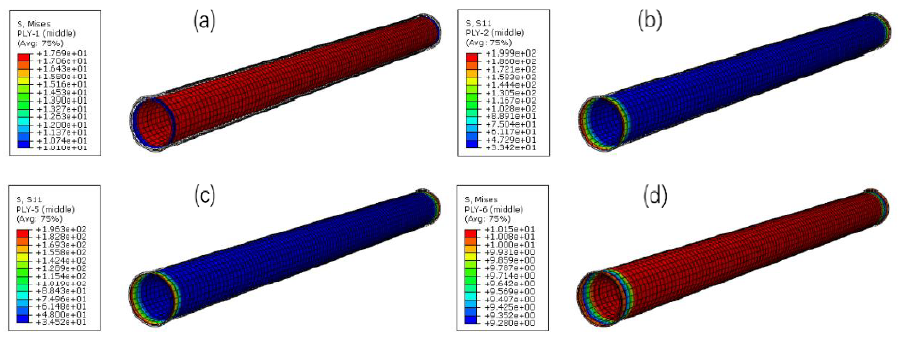
Figure 8. Stress distributions of each layer of the RTP at the axial tensile displacement of 100 mm: ( a ) liner; ( b ) the first reinforced layer; ( c ) the fourth reinforced layer; ( d ) outer cover.